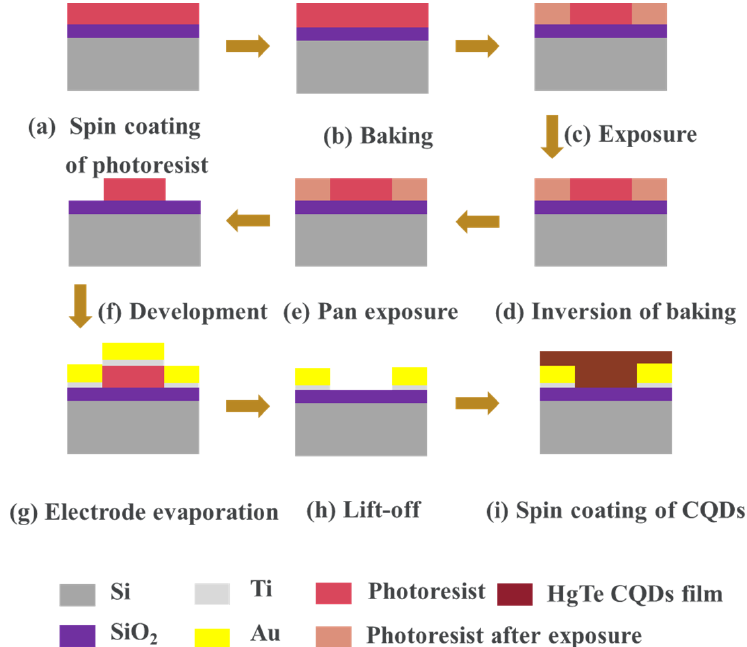
Figure 5. Flow chart of device fabrication: ( a ) spin coating of photoresist; ( b ) baking; ( c ) exposure; ( d ) inversion of baking; ( e ) pan exposure; ( f ) development; ( g ) electrode evaporation; ( h ) lift-off; ( i ) spin coating of CQDs.